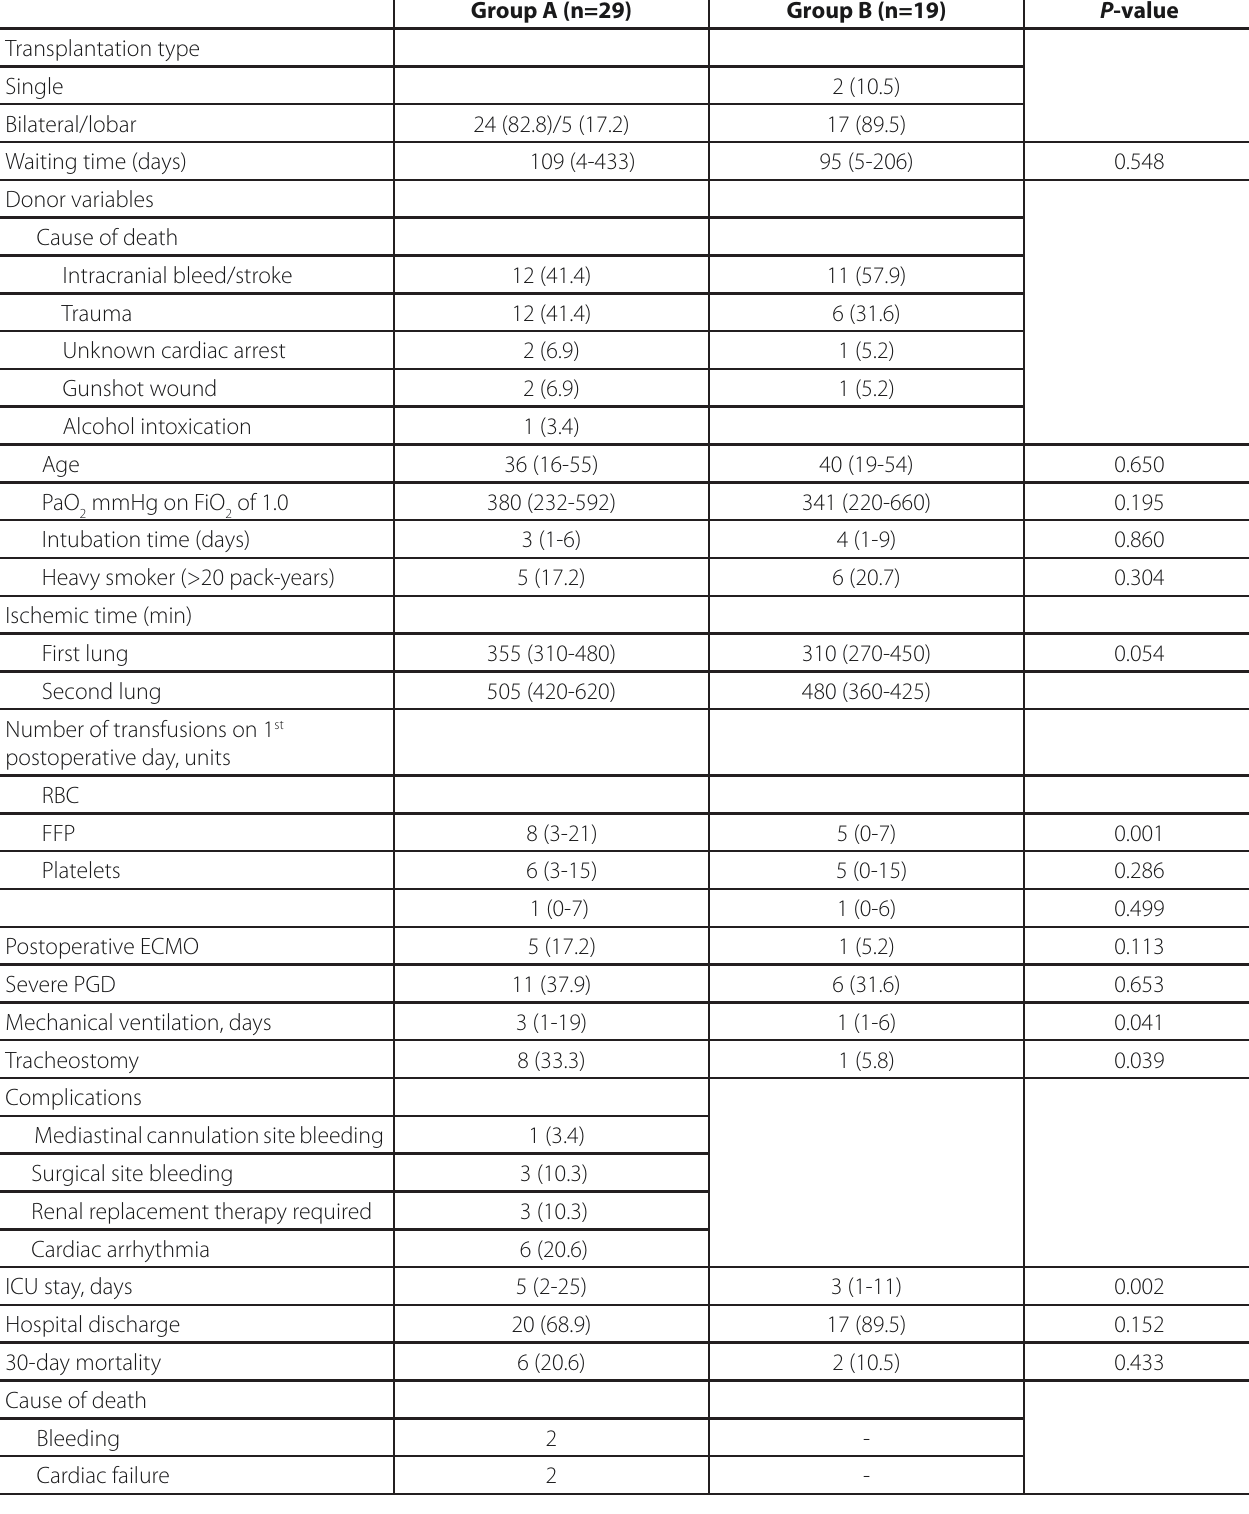
Table 2. Intraoperative data and outcomes. Group A (n=29) Group B (n=19) P